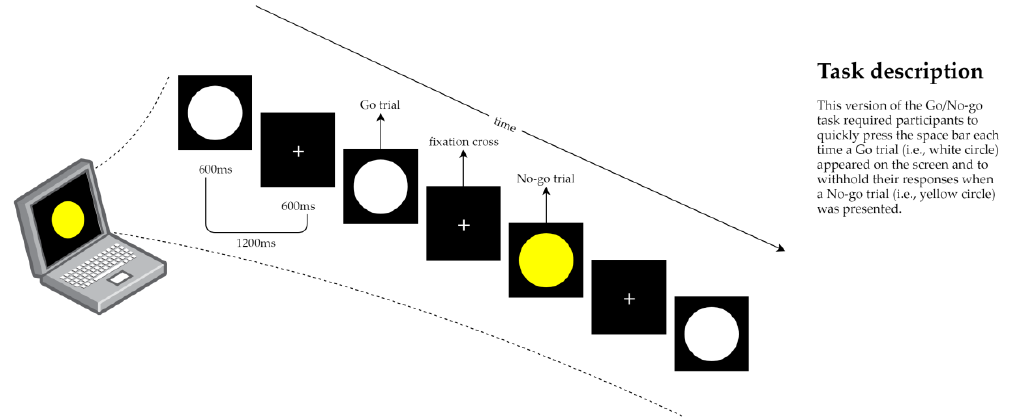
Figure 2. Graphical representation of the Go/No-Go task protocol, based on the paradigm originally proposed by Donders [38].